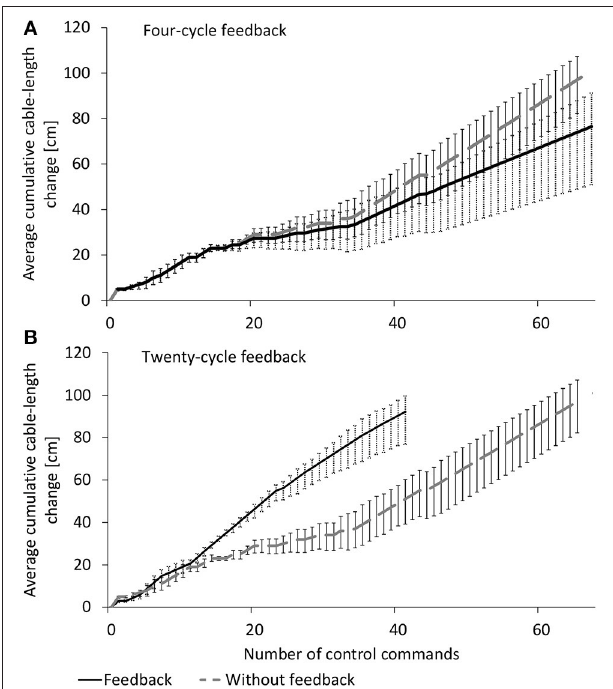
FIGURE 9 | Average cumulative cable-length change for measured deployment with and without feedback control in (A) four cycles and (B) twenty cycles of equal structure deployment length for twenty trials. Two standard deviations of end-node position error are shown. Cable-length changes without feedback (gray dashed line) are the same for (A,B) .